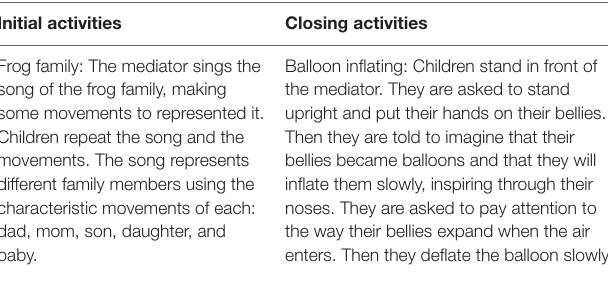
TABLE 2 | Examples of initial and closing